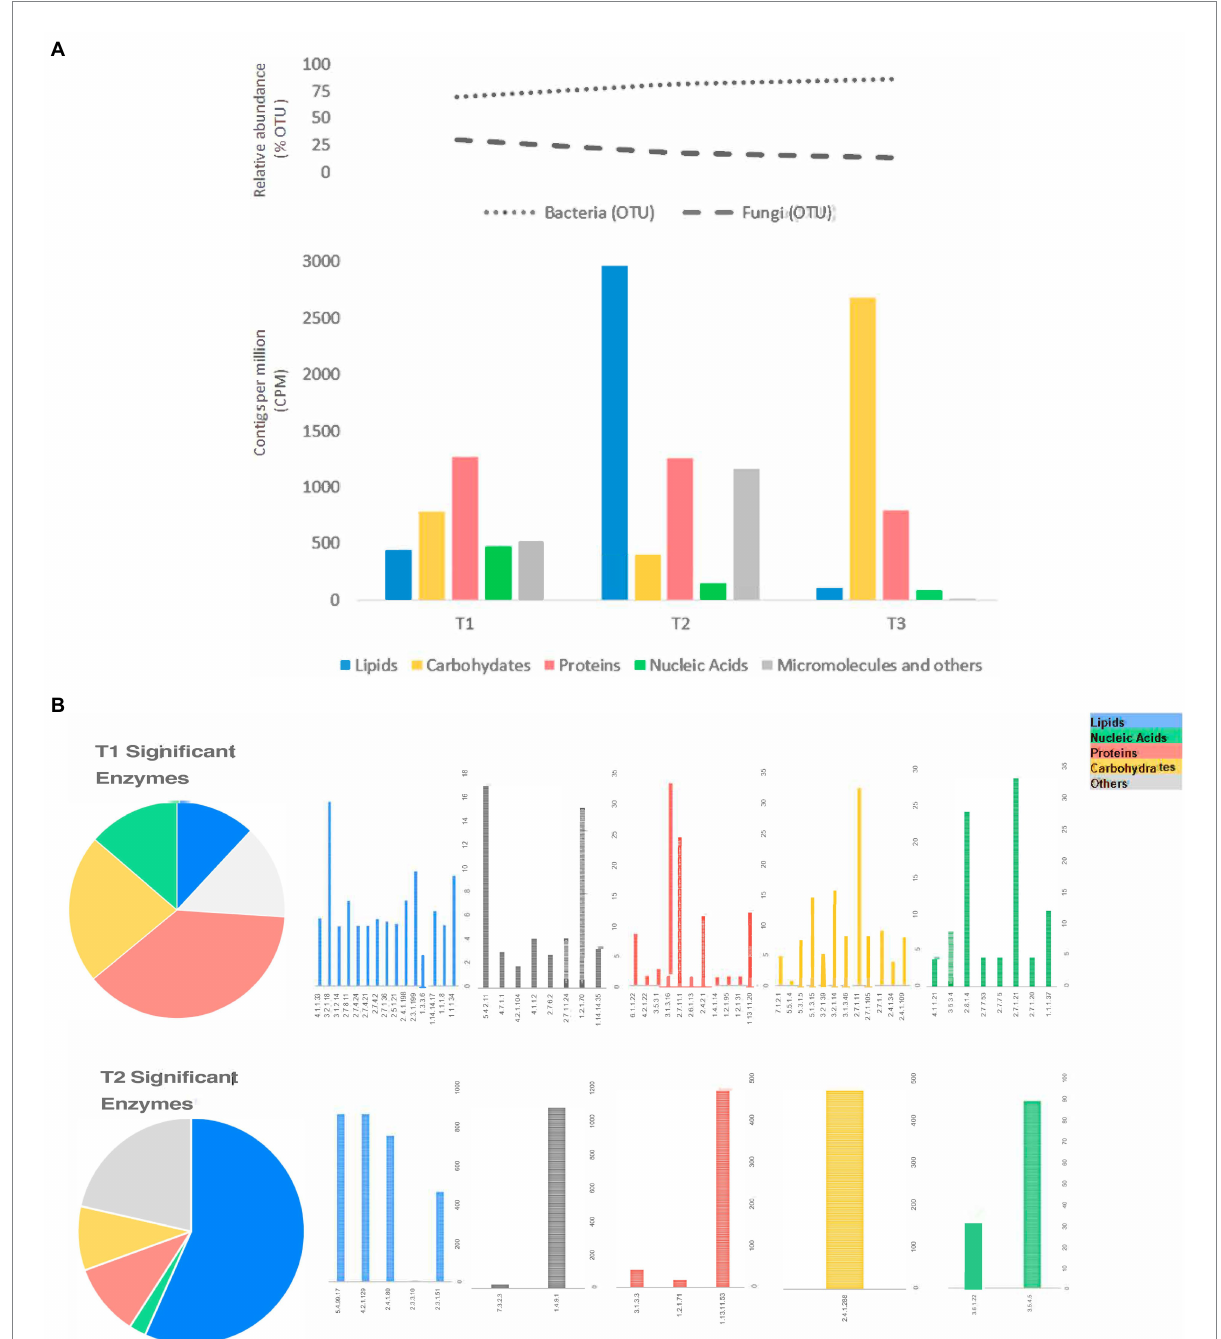
FIGURE 3 (A) Relative abundance of bacteria and fungi (%). (B) CPMs of potential exclusive or dominant enzymes related to essential metabolic pathways during cocoa fermentation: T1 (24 - 48h), T2 (72 - 96h), and T3 (120 -